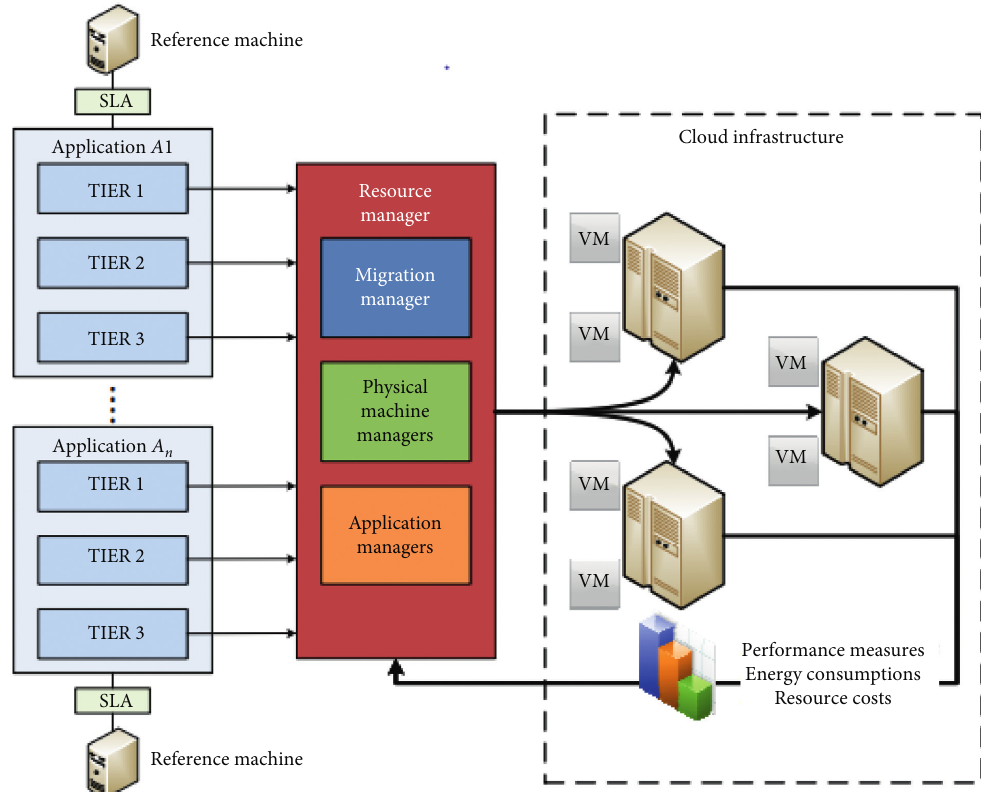
Figure 4: Framework of the proposed three-fold system